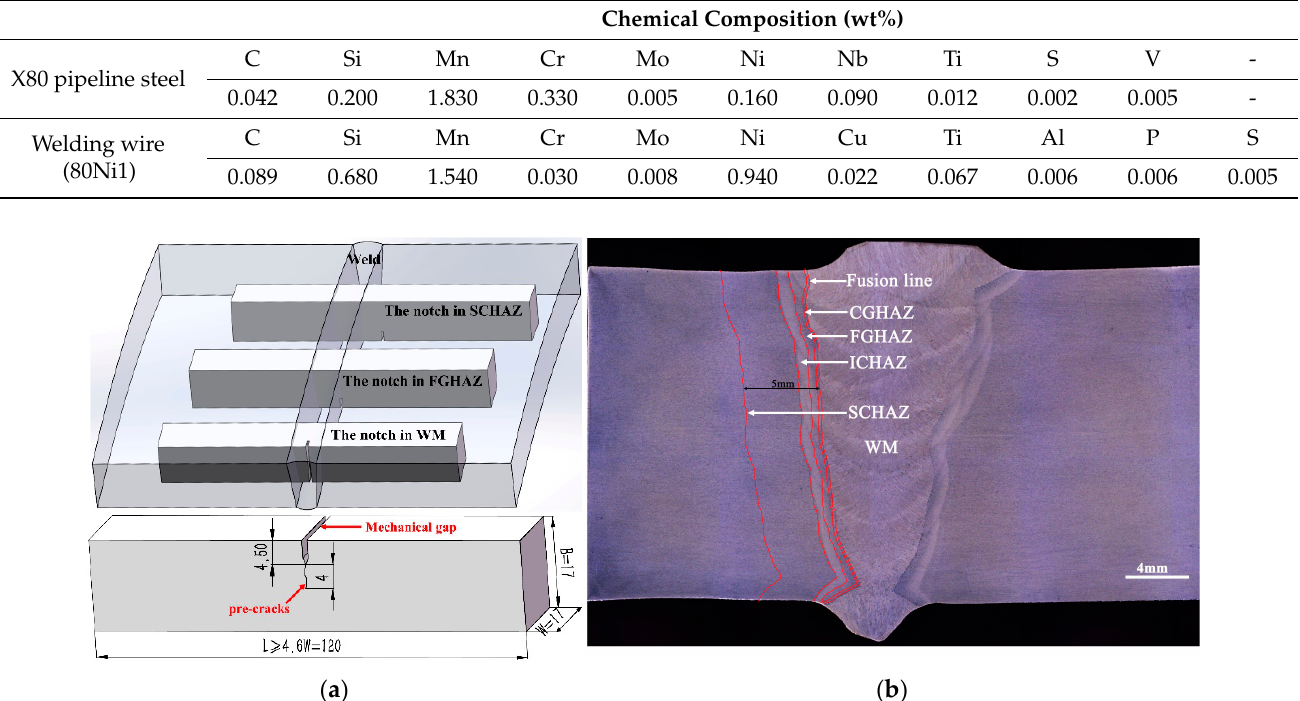
Figure 1. Sampling location of CTOD and macroscopic photograph of the welded joint: ( a ) sampling location of CTOD; ( b ) macroscopic photograph of the welded joint.